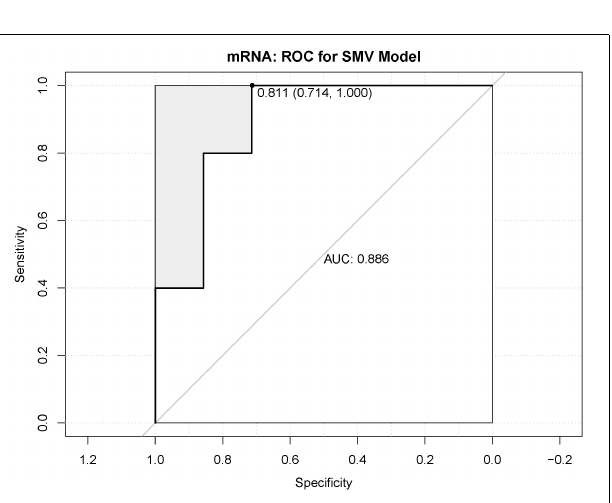
FIGURE 7 | Receiver operating characteristic (ROC) analysis of support vector machine (SVM)